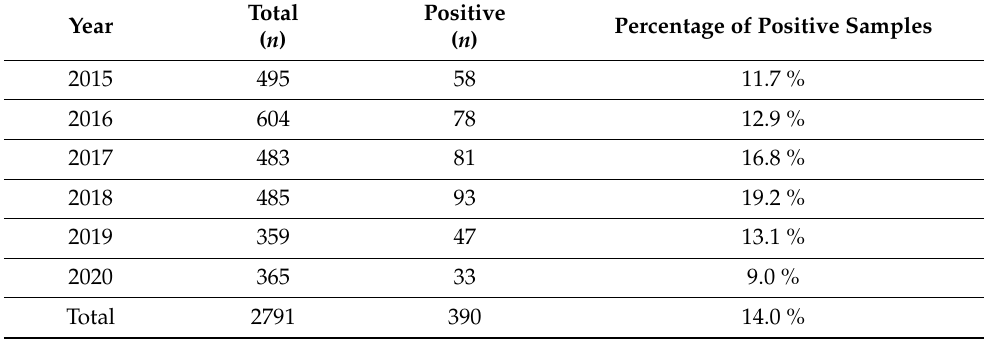
Table 2. Yearly percentages of samples resulted positive to isolation of Salmonella spp.